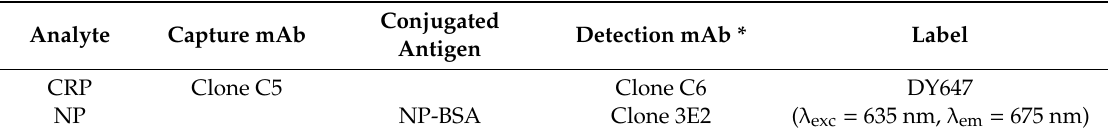
Table 1. Combination of capture (mAb) and detection (mAb *) antibodies for CRP and conjugated antigen and detection mAb * for NP. The label of the detection monoclonal antibodies (*) is also indicated.